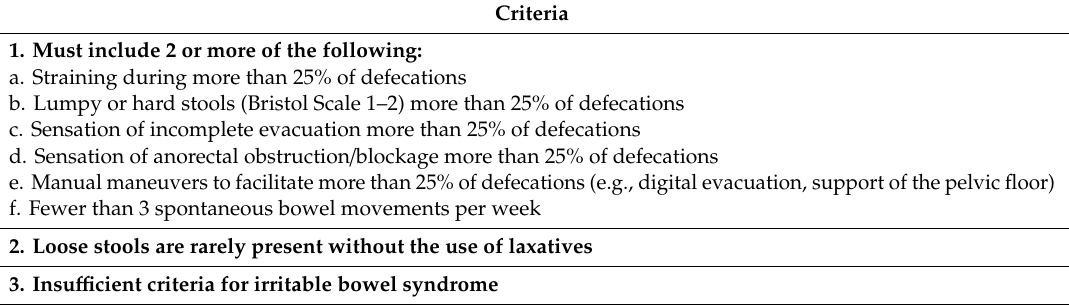
Table 1. Rome IV criteria for the diagnosis of functional constipation